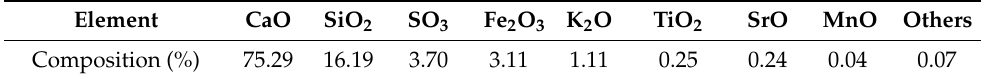
Table 1. Chemical composition of cement Portland CPII-Z-32 [45].